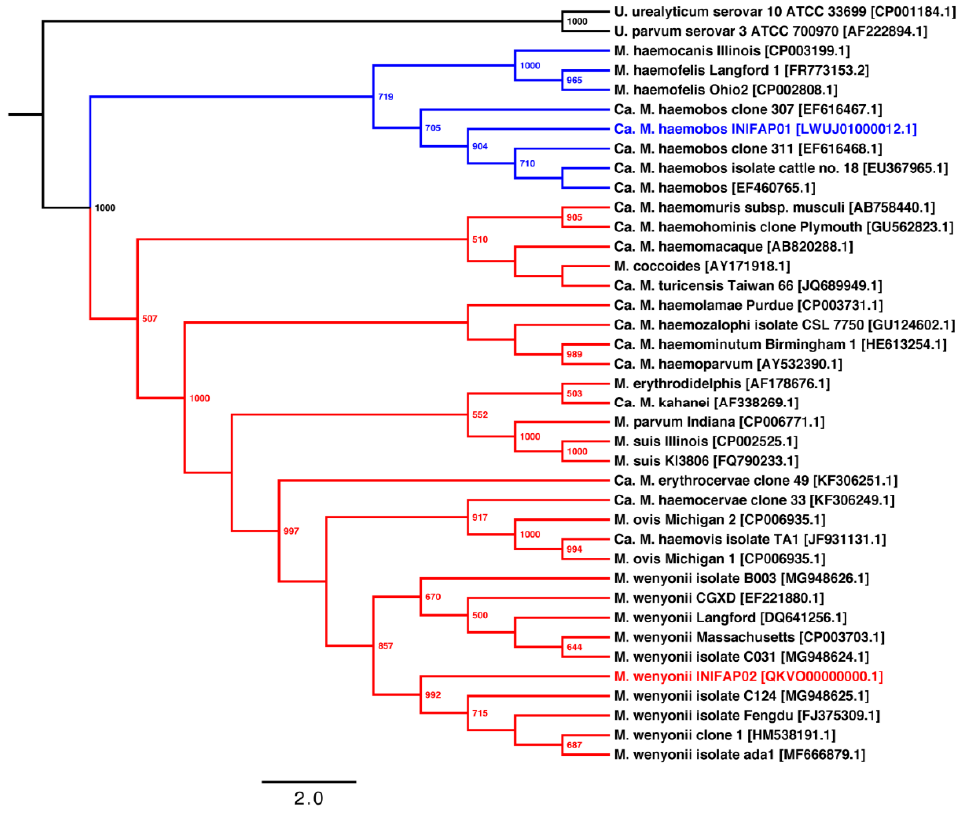
Figure 2. Phylogenetic relationships based on the 16s rRNA genes of group 1 (blue lines) and 2 (red lines) of hemoplasma species. The phylogenetic tree was obtained using the PhyML program with the maximum likelihood method and 1000 bootstrap replicates. Bootstrap values (>50%) are displayed in the nodes. The model of nucleotide substitution was GTR + I + G. The INIFAP01 and INIFAP02 Mexican strains of bovine hemoplasmas are shown in blue and red letters, respectively. GenBank accession numbers are shown in square